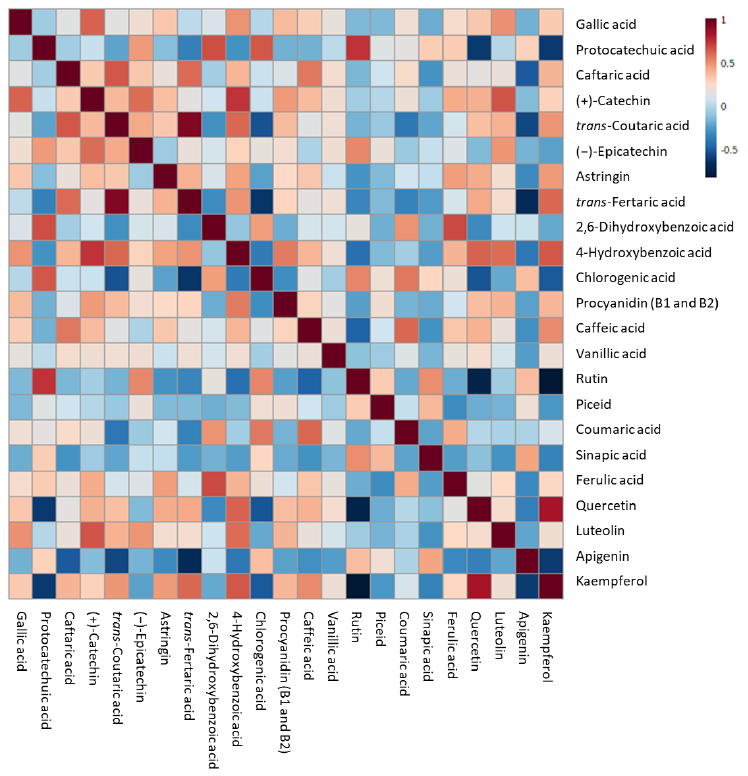
Figure 5. Heatmap representation of the correlation analysis between the log-transformed (poly)phenol concentration of different sub-samples of IGA and control beers. Each square indicates Pearson’s correlation coefficient value R 2 . Red and blue represent positive and negative correlation, respectively.